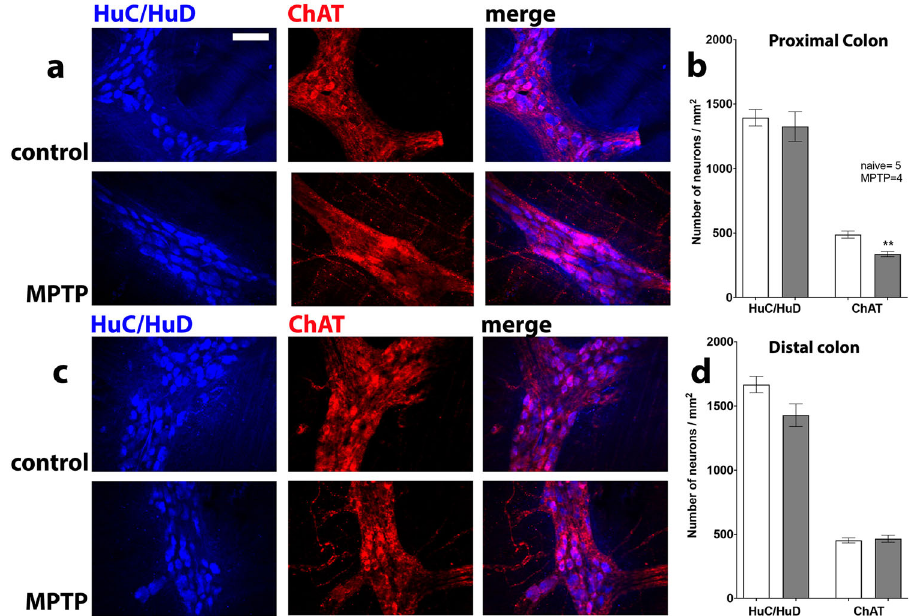
Fig. 8 Effect of MPTP treatment on ChAT / HuC/HuD-ir neurons in the proximal and distal colon. Panels ( a , b ) show proximal and ( c , d ) show distal colon. Quantitative analysis of HuC/HuD- and ChAT-ir neurons in MPTP-treated marmosets compared to na ϊ ve controls in the proximal and distal colon is shown in panels ( b ) and ( d ), respectively. The number of immunoreactive neurons are expressed as mean ± SEM. ** P < 0.01 compared to naïve control (Students t -test). The scale bar in panel ( a ) indicates 100